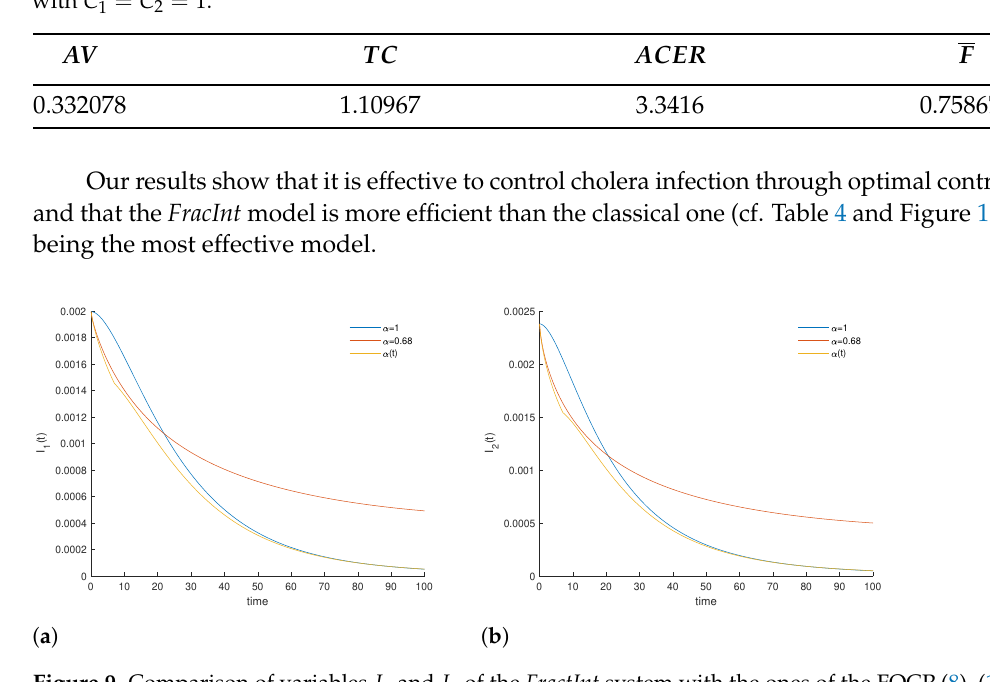
Figure 9. Comparison of variables I 1 and I 2 of the FractInt system with the ones of the FOCP (8)–(13) with α = 1 and α = 0.68, considering the parameter values from Table 1. ( a ) Infected individuals of 1st community; ( b ) Infected individuals of 2nd community.